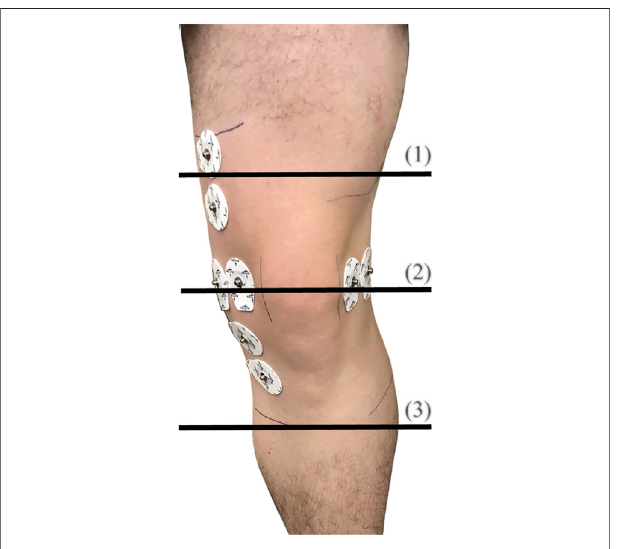
FIGURE 4 | Circumference measurements around the knee at three